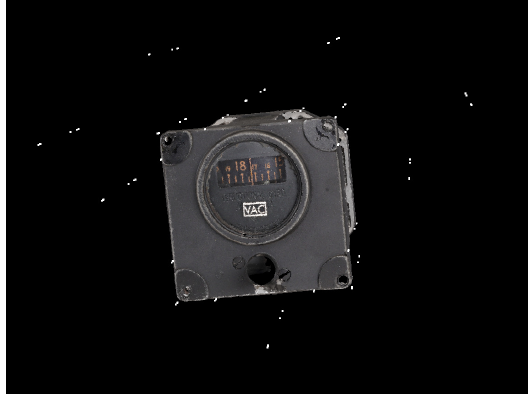
Figure 8. Virtual control points of photogrammetric